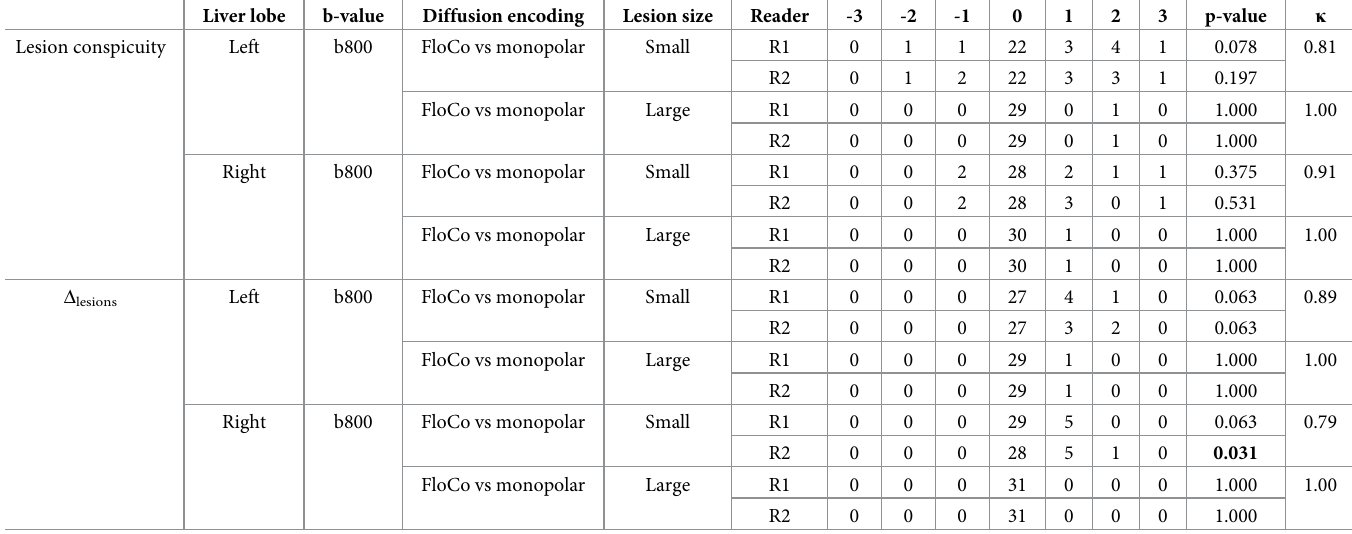
Table 5. Lesion conspicuity and the difference in detectable lesions ( Δ lesions ) (same data as in Fig